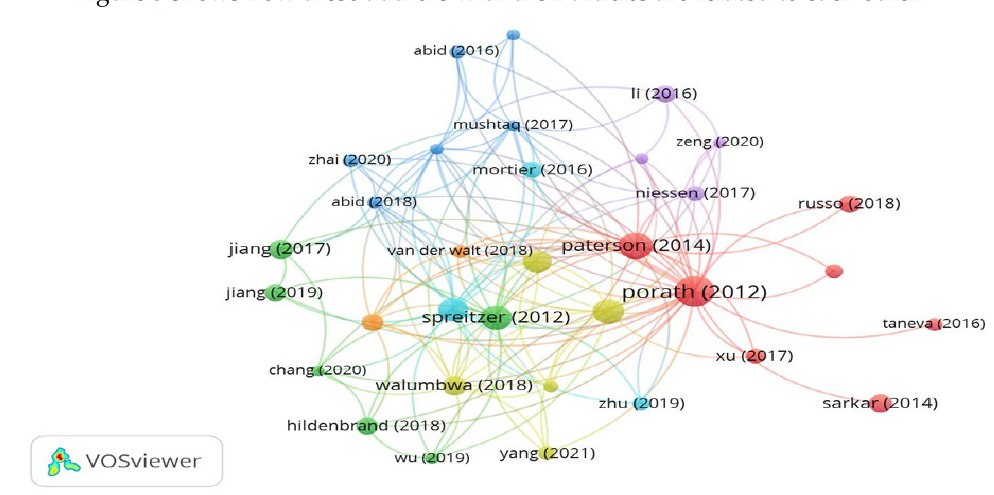
Table 3. Highly cited journals in the topic of thriving at work organized by several citations.